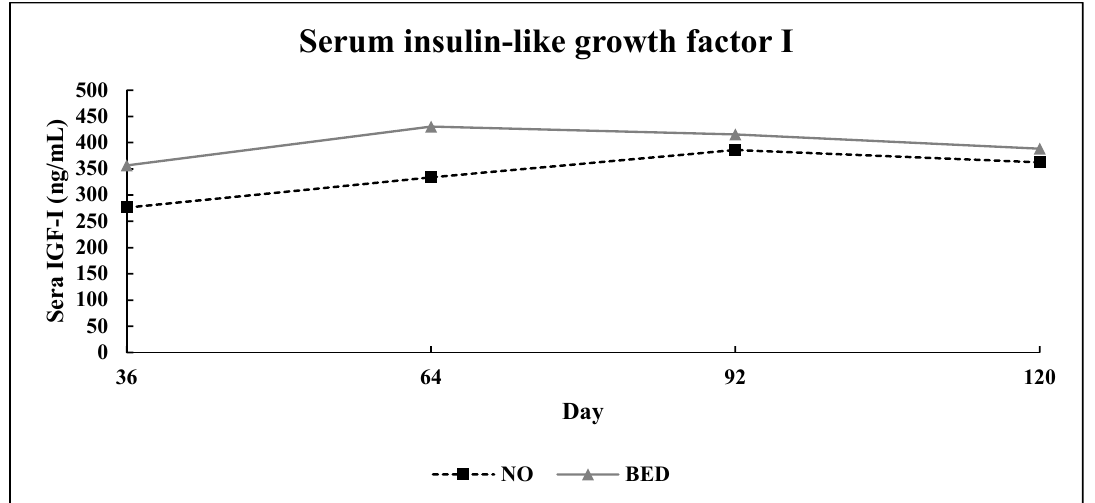
Figure 4. Experiment 1: Effect of bedding treatment on serum concentration of insulin-like growth factor I (IGF-I) in finishing steers ( n = 15 pens / treatment; pooled bed × day SEM (Standard error of the mean) = 25.71). Treatments were: No bedding applied (NO) and 1.8 kg (as-is basis) of wheat straw